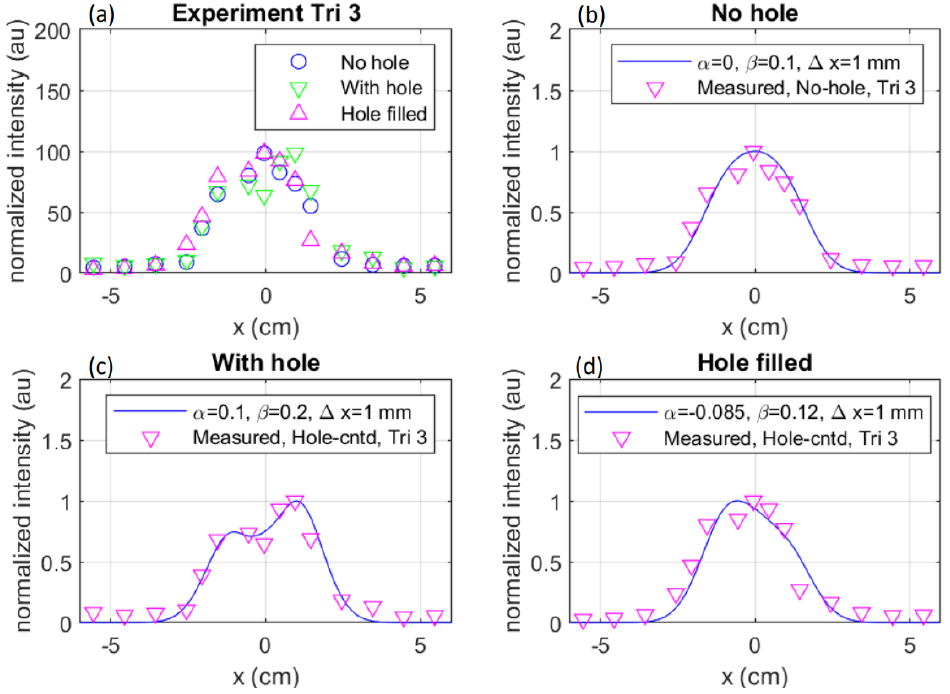
Figure 12. ( a ) Measured sensor signals; ( b ) Hermite–Gaussian fit for the No Hole case; ( c ) Hermite– Gaussian fit for the Hole case; ( d ) Hermite–Gaussian fit for the Hole Filled